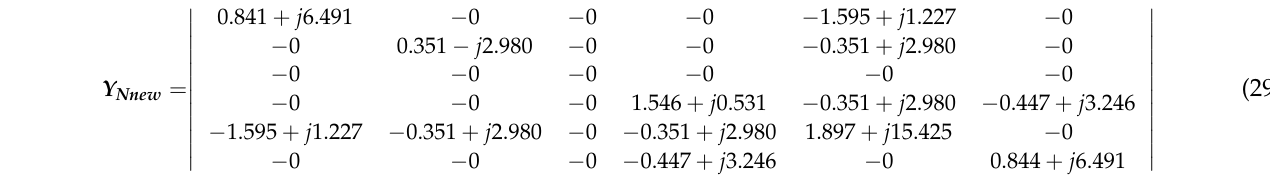
Figure 7. Nigerian 330 kV Eastern Grid Network with Delta PS to Onitsha line out of service [22]. With branch 4 out of service, the resultant network admittance becomes Y Nnew and the corresponding eigenvalues and eigenvectors of the network became altered as (29) and the right eigenvector is represented in Table